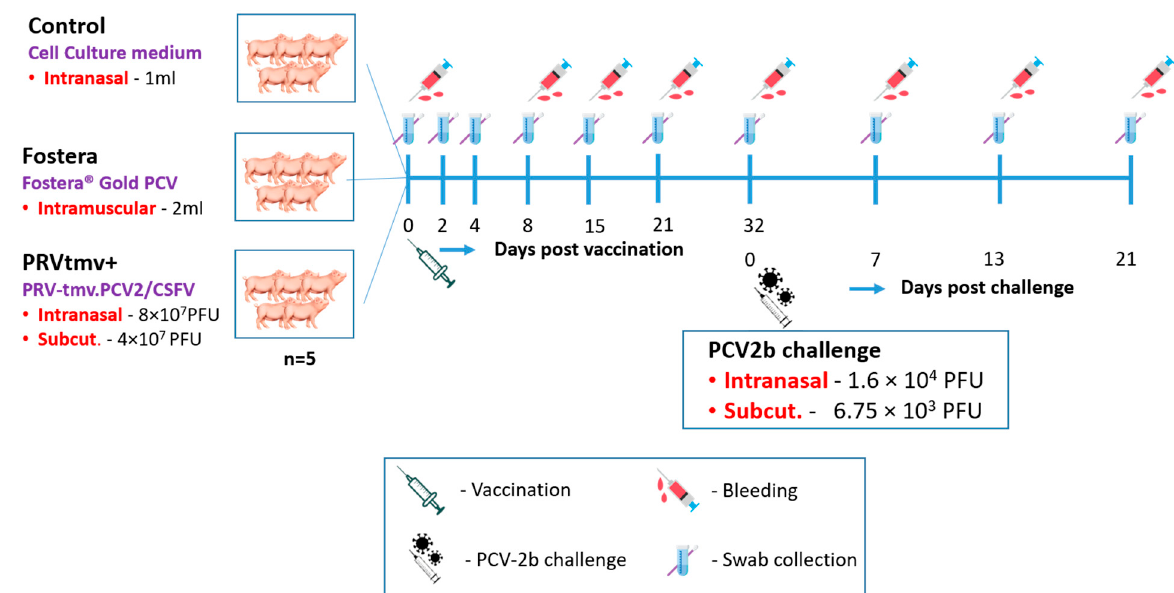
Figure 3. Vaccination, sample collection, challenge, and euthanasia scheme for the animal experiment. Intranasal (IN)—intranasal inoculation; Subcut—subcutaneous injection; PFU—plaque-forming units.